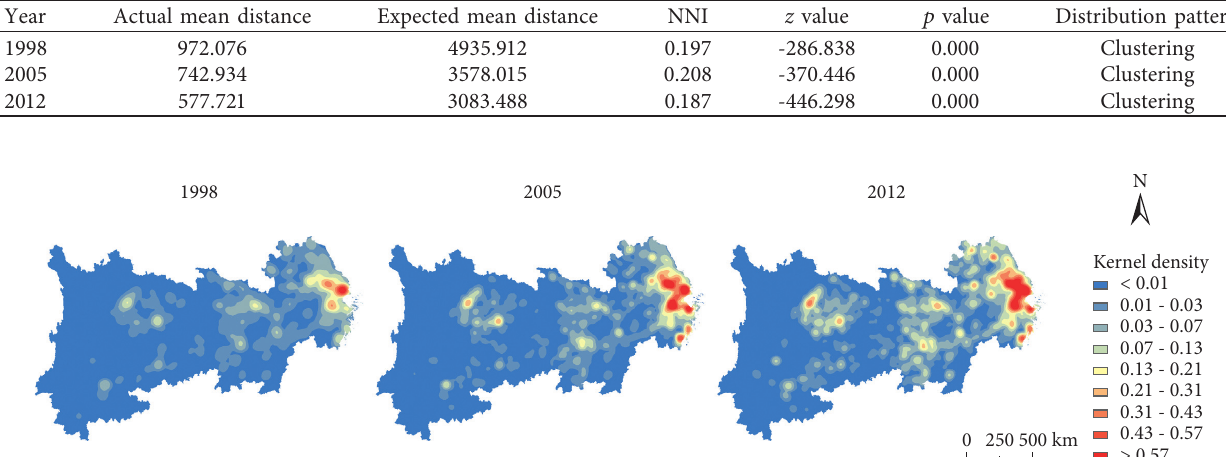
Figure 3: Kernel density estimation of water pollution-intensive enterprises in the Yangtze River Economic Belt.